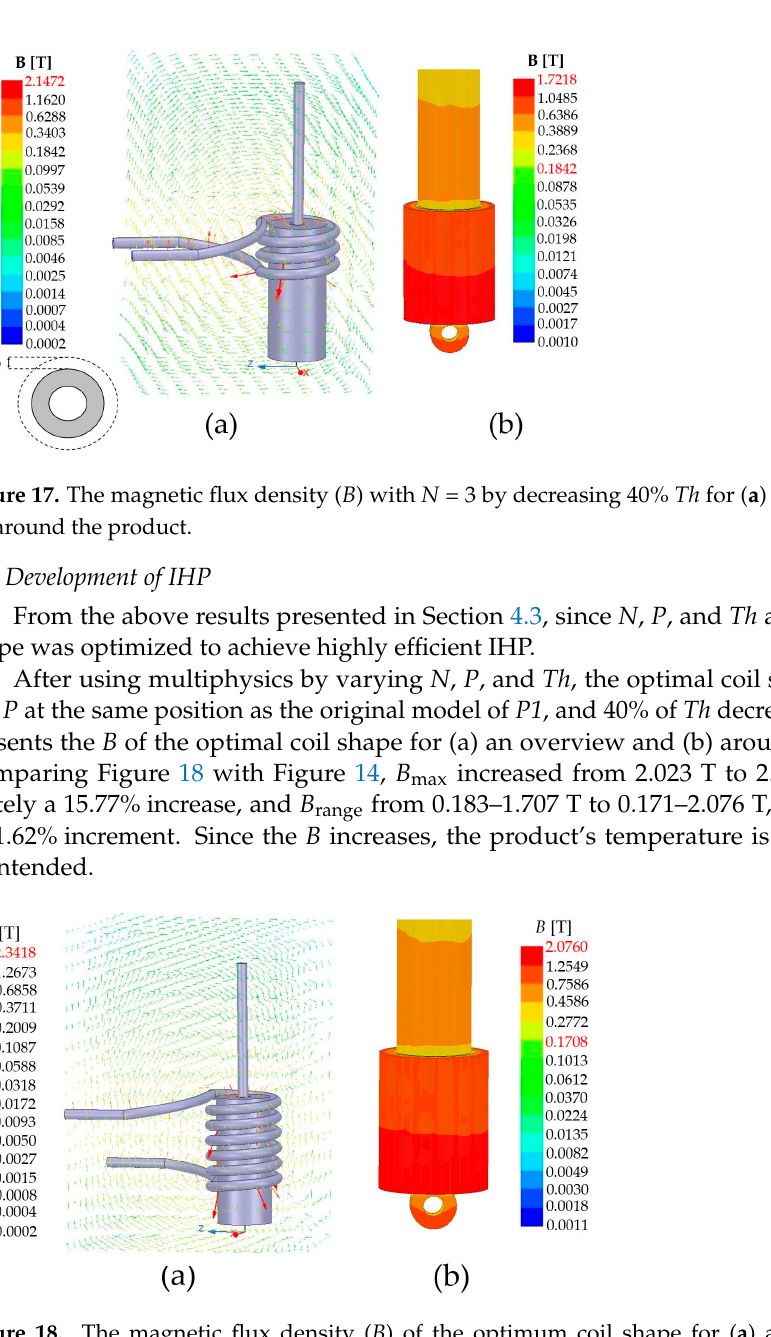
Figure 18. The magnetic flux density ( B ) of the optimum coil shape for ( a ) an overview and (b ) around the product.